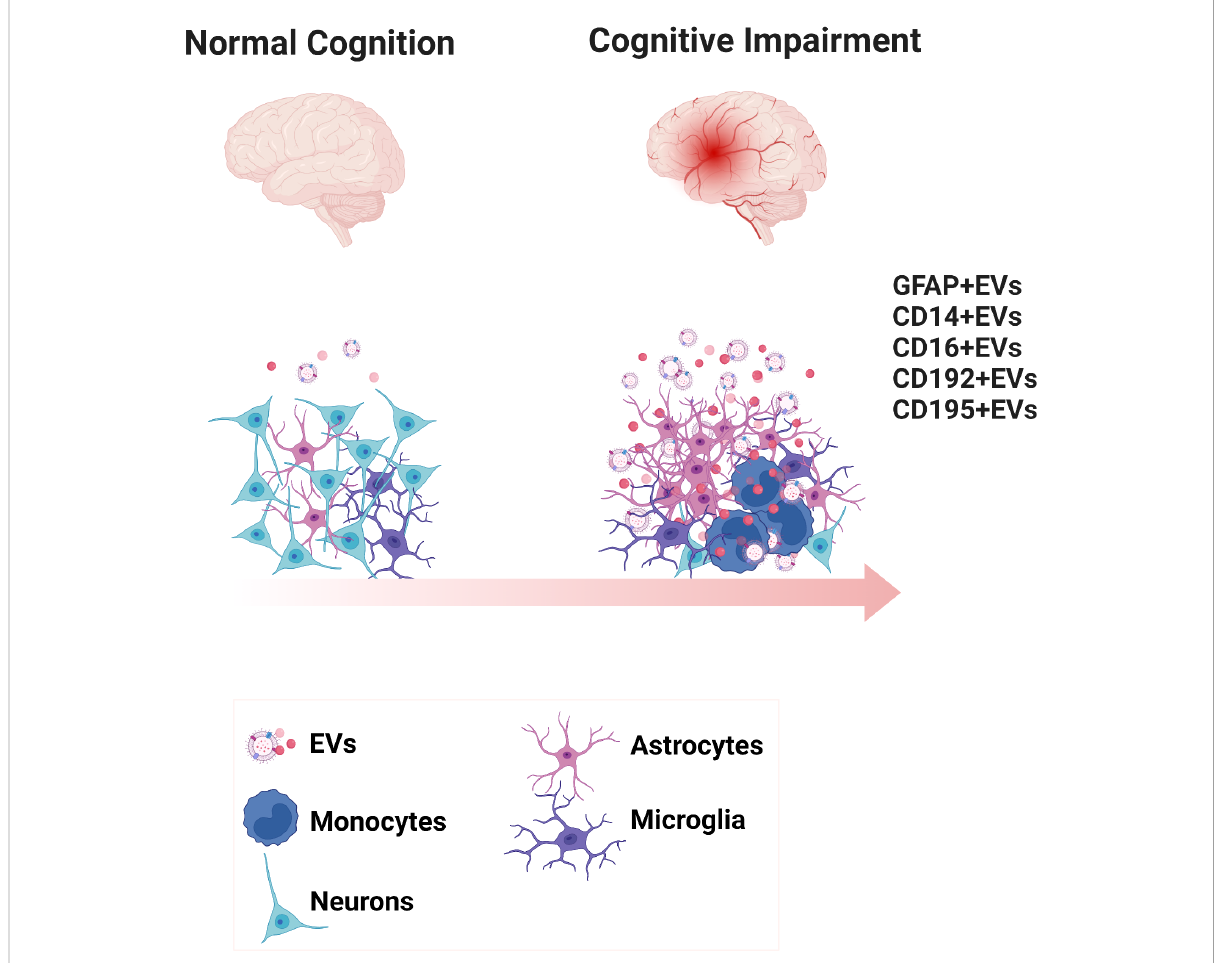
FIGURE 6 Diagrammatic representation of the biogenesis of EVs expressing in fl ammatory phenotypic markers in neurocognitive disorders. Scheme presents the healthy brain and the in fl ammatory environment of the cognitively impaired brain. EVs are generated re fl ecting the underlying surface proteins on their cell of